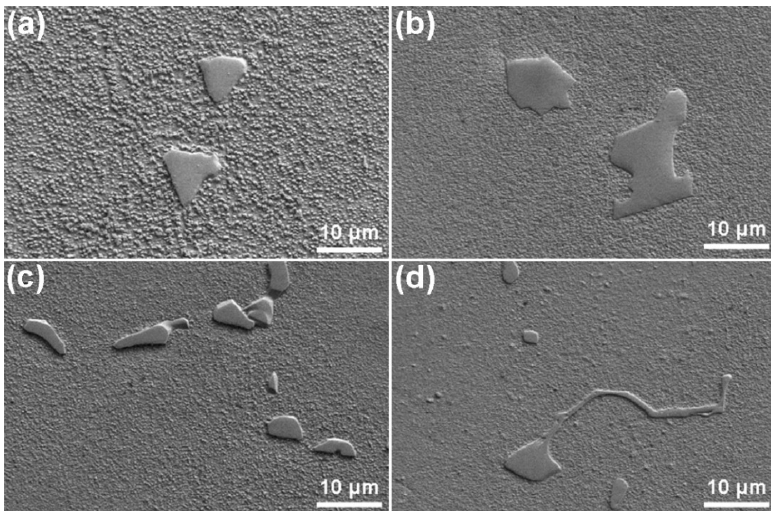
Figure 2. SEM images of the as-cast GTD222 superalloy with different cooling rates during the solification process, ( a ) cooling at 2.5 K / min, ( b ) cooling at 5 K / min, ( c ) cooling at 10 K / min, ( d ) cooling at 20 K / min.